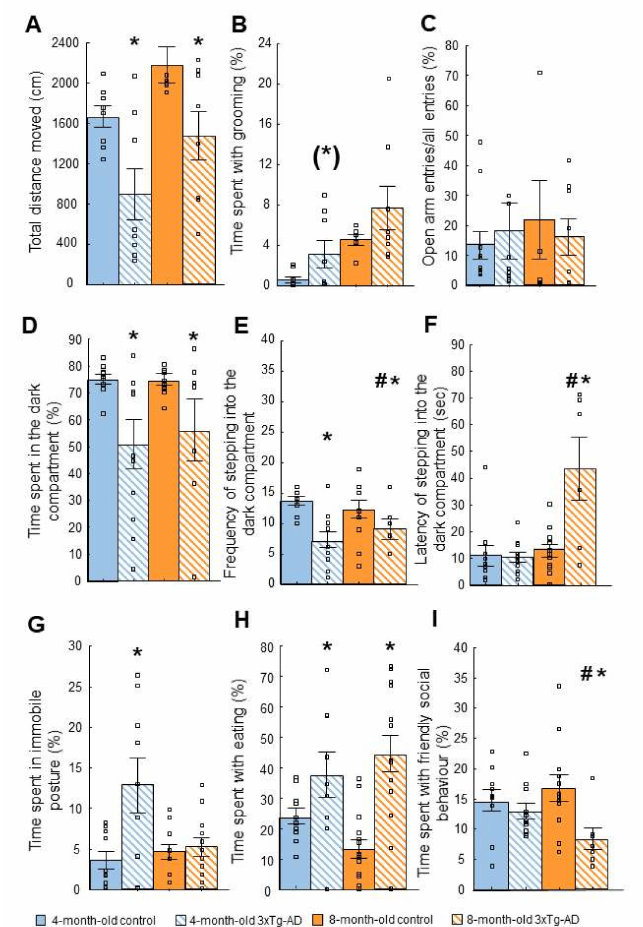
Figure 2. Anxiety-like behavior. ( A , B ): Open field (OF) test. ( A ): There was a significant difference in time spent in immobile posture: 3xTg-AD mice spent significantly less time with active movement and more with immobility compared to control both in 4- (* p = 0.02) and in 8-month (* p = 0.04) groups. ( B ): 3xTg-AD animals in both age groups spent more time with self-grooming than the controls, however, the difference was only marginally significant ((*) p = 0.09). For 8-month group, this difference was further reduced ( p = 0.24). ( C ): Elevated plus maze (EPM) test. There was no significant difference between genotypes either in the classical parameters (open arm time, data not shown), or in locomotion-independent anxiety parameter, the % of open arm frequency. ( D – F ): Light-dark (LD) test. ( D ): Significant difference was found between genotypes in percentage of time spent in the dark compartment of the box (genotype: * p = 0.00). ( E ): The frequency of stepping into the dark compartment was also significantly lower in the 3xTg-AD mice compared to the controls (genotype: * p = 0.00). ( F ): There was also a significant difference in the latency of stepping into the dark compartment in case of the 8-month-old animals, 3xTg-AD mice entered later than the controls (age*genotype: * p = 0.04; 8-month-old post-hoc: # p = 0.01). ( G – H ): Novelty suppressed feeding (NSF) test. ( G ): There was a significant difference in the time spent with immobility between genotypes in both age groups (genotype: * p = 0.03). More precisely, 4-month-old 3xTg-AD mice spent more time with this behavior than their controls, which suggested enhanced anxiety-like behavior. ( H ): 3xTg-AD mice spent more time with eating without age difference (genotype: * p = 0.00). ( I ): Social interaction (SI) test. There was a significant difference between genotypes in the time spent with social behavior in case of the 8-month-old animals with age difference (age*genotype: * p = 0.05; 8-month-old post-hoc: # p = 0.01). The 3xTg-AD mice spent less time with friendly social behavior compared to the